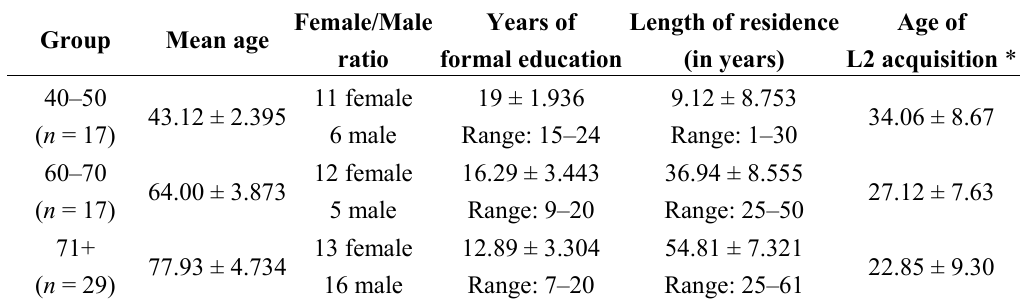
Table 1. Demographic information of participants, split per age